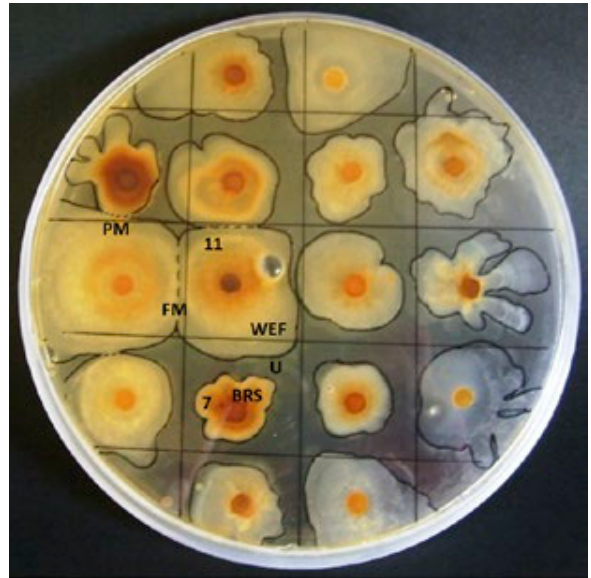
Figure 4. Pigmentation, shape, growth rate, and merging among Geosmithia morbida isolates 21 d after incubation. W, whitish-orange; B, orange-brown; E, mainly even; R, mainly rough; F, fast, average diameter ≥ 3 cm; S, slow, av - erage diameter < 3 cm; FM, fully merging, contact ≥ 4 mm; PM, partially merging, contact < 4 mm; U, unmerging, no contact. Isolates 7 and 11 are representatives used to obtain monoconidial strains. Black lines along the colony perim- eters on the plate back were used for growth comparisons between the observation